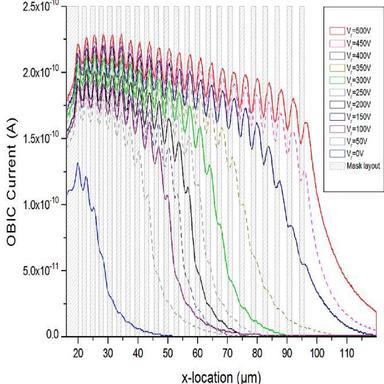
OBIC currents for various reverse voltages (ranging from 0 V to 500 V by 50 V step) at the diode periphery. The grey color corresponds to the mask layout with the ring spacing.